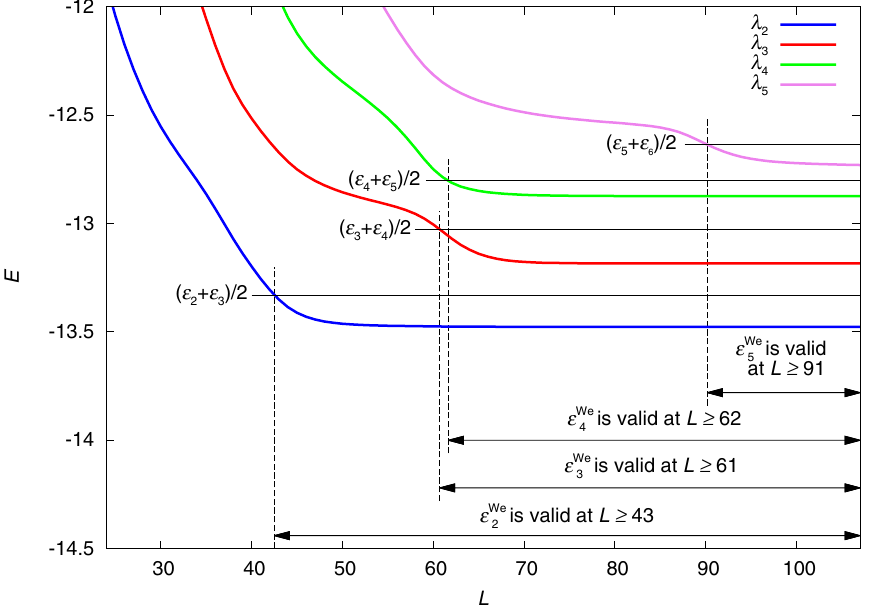
Figure 1. Ranges of validity of the Weinstein lower bound according to Eq. (18) for the Hubbard model. The blue, red, green, and violet lines indicate energy eigenvalues (cid:31) 2 , (cid:31) 3 , (cid:31) 4 , and (cid:31) 5 as a function of dimensionality L of the Lánczos basis set, respectively. The graphs of the eigenvalue functions were intersected by the line of the condition of validity. As the true energy levels ε j are not known, the lowest eigenvalues (cid:31) 117, j are used. The Weinstein lower bounds are valid from the L value greater than the point of intersection.